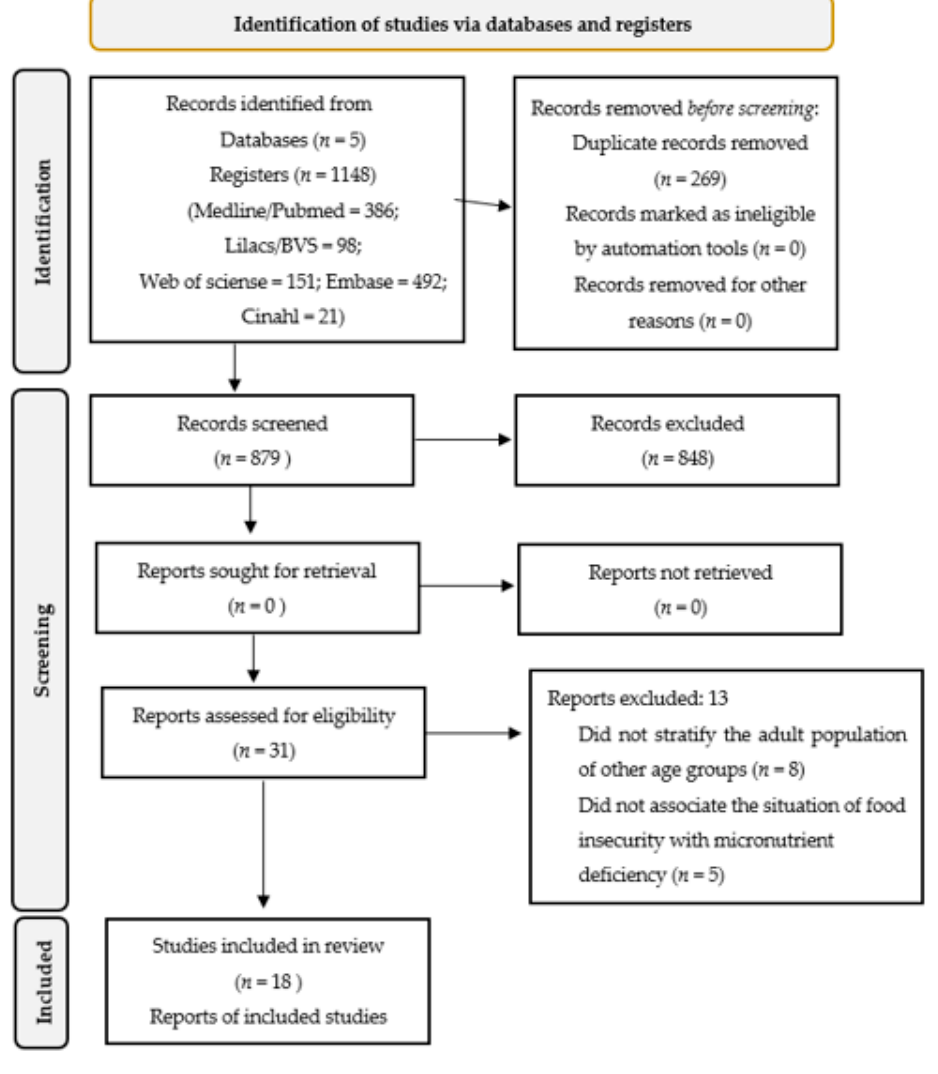
Figure 1. Scheme of the methodology adopted for the systematic review [14]. Table 1. Description of the included studies: author, year, country, sample, and objectives.